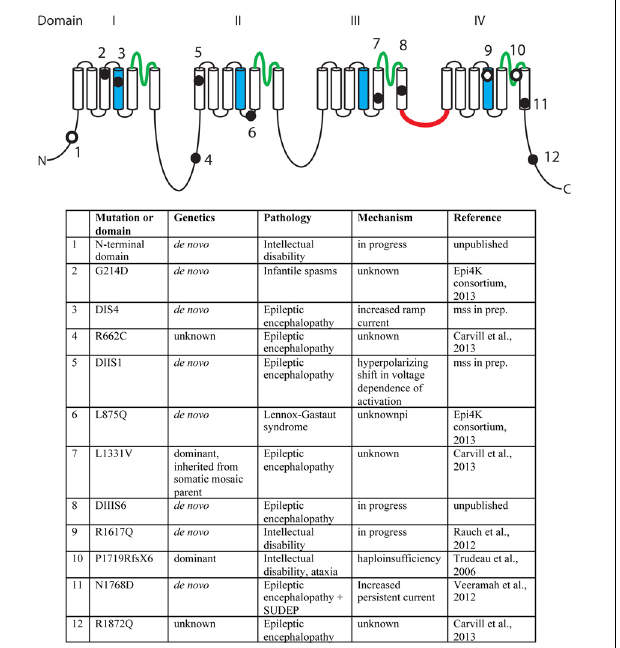
applied every 5s. Insets show persistent inward currents (normalized by maximal transient peak currents) from WT and p.Asn1768Asp channels at